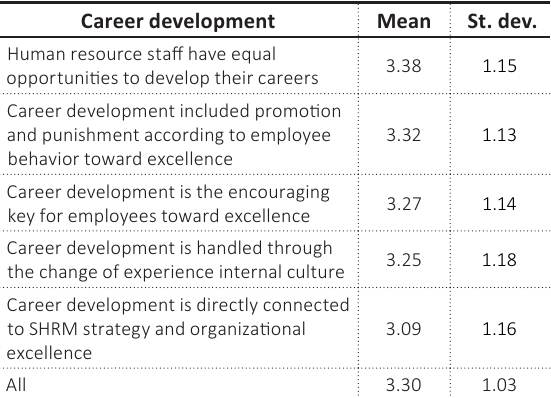
Table 5. Managers’ attitudes for the role